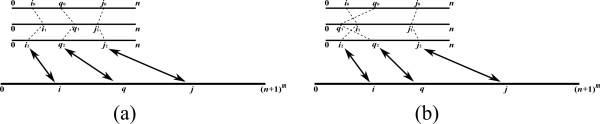
The h mapping. The notations X, Y, and Q, refer to the positions (i1, i2, i3), (j1, j2, j3) and (q1, q2, q3) which are illustrated in the figure, respectively. (a) A position Q ∈ (X, Y) is mapped to an index q ∈ (i, j), where i = h(X) and j = h(Y). (b) Some indices q ∈ (i, j) correspond to positions Q = h-1(q) such that Q ∉ (X, Y). This implies that either SX, Q or SQ, Y are not valid sub-instances of S.